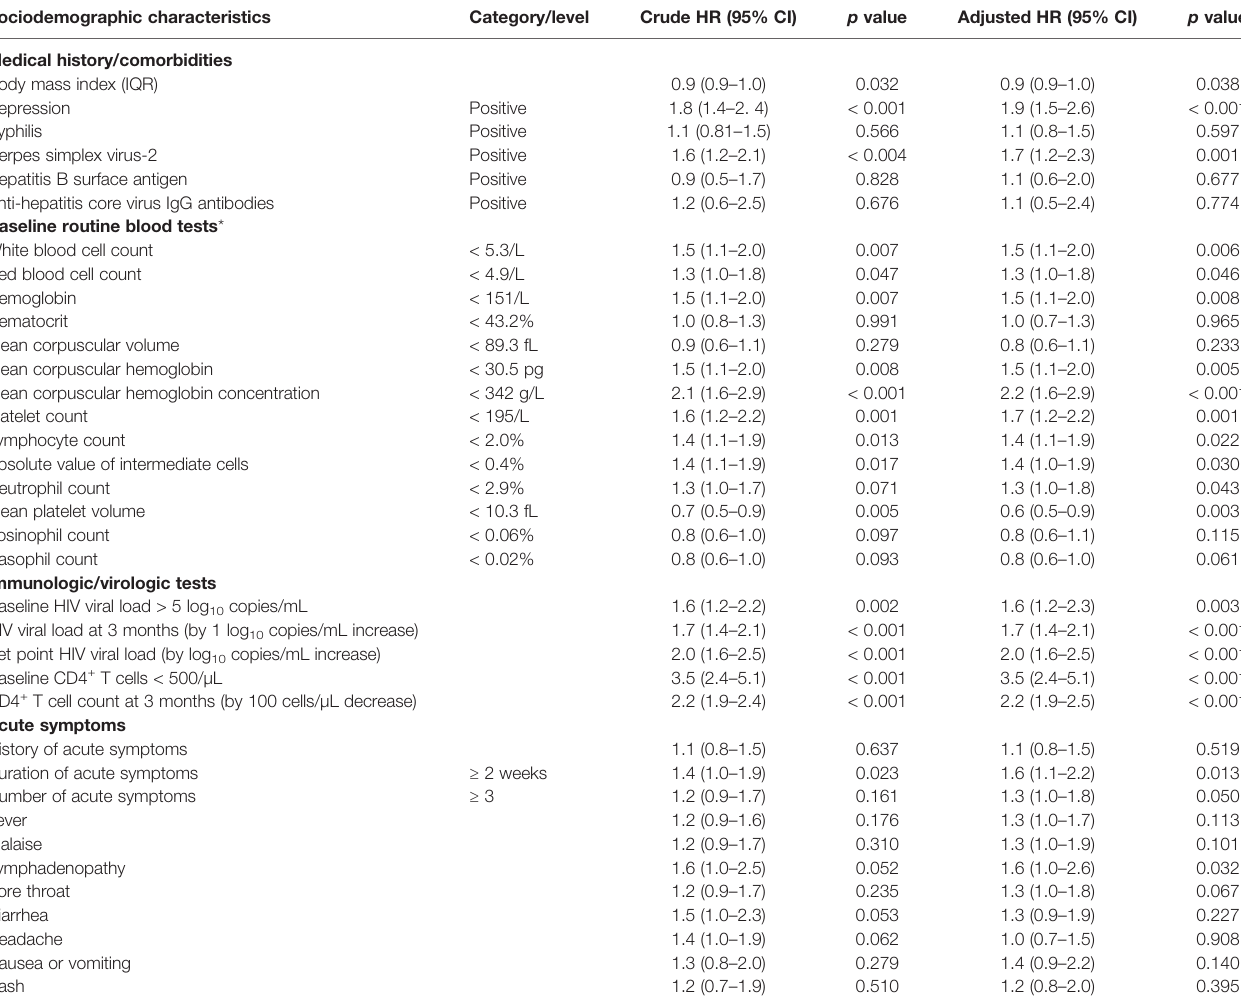
TABLE 2 | Factors associated with rapid HIV disease progression (CD4 + T cell count < 350/ m L within 2 years of infection) according to Cox regression analysis ( n = 291). Sociodemographic